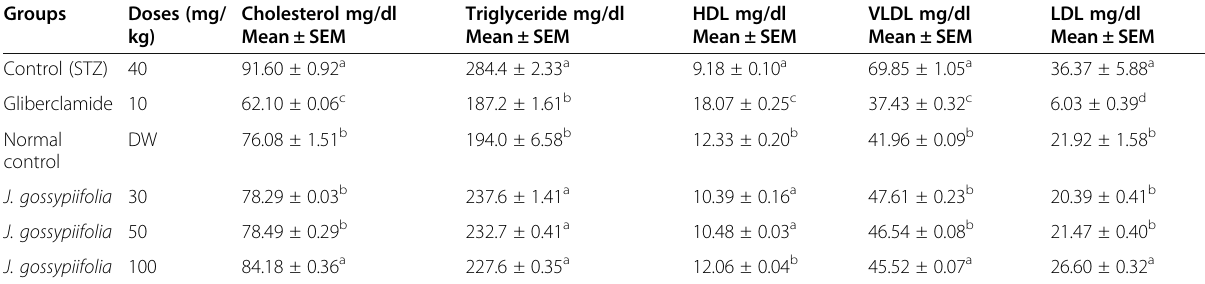
Table 6 Effect of J. gossypiifolia on lipid profile test on day 14 Groups